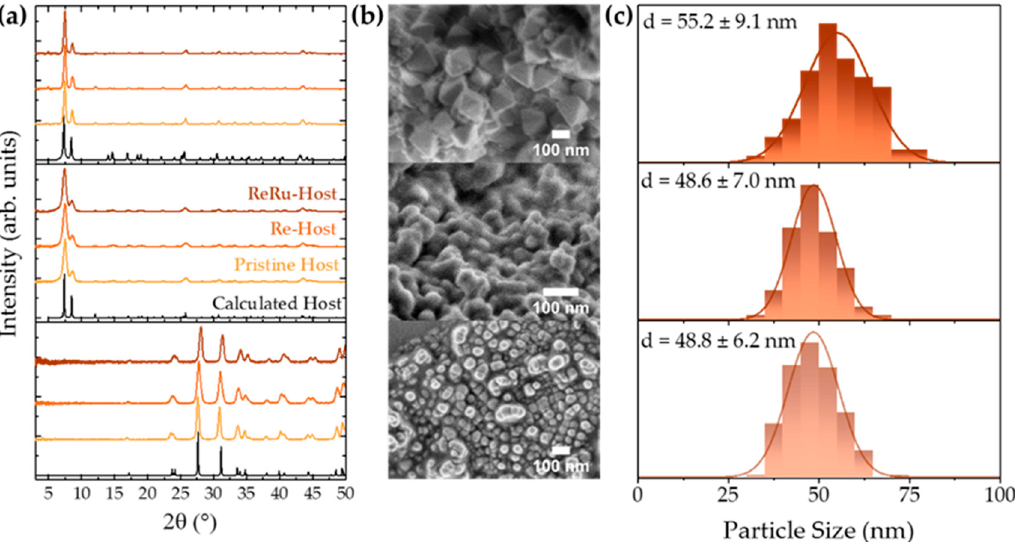
Figure 2. Characterization of 66-NH 2 -based (top), 66-based (middle), and ZrO 2 -based (bottom) assemblies. ( a ) Powder X-ray diffraction (PXRD) data with calculated reflexes (black) from single crystal data for each material, respectively. ReRu-Host samples are R = 0.5. ( b ) Representative SEM images for each pristine host. ( c ) Particle size distributions calculated from SEM images for unmodified host materials. Obtained from Figures 2b and S3–S5.